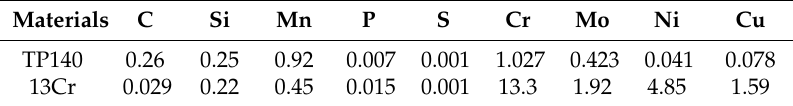
Table 2. Mechanical properties of TP140 and 13Cr steel.